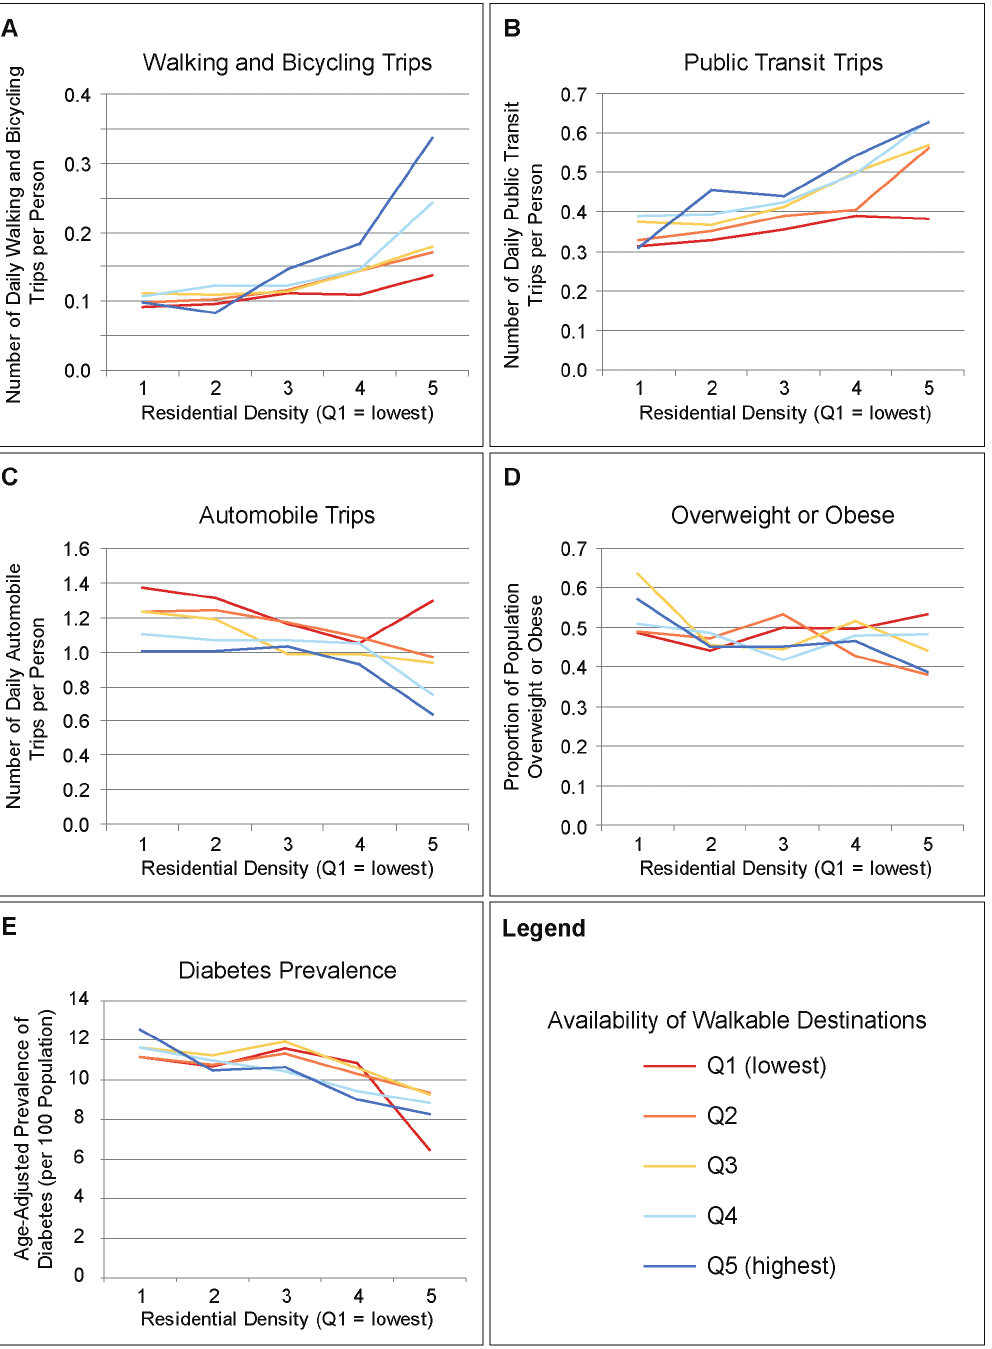
Figure 2. Transportation Behaviors and Health Outcomes by Residential Density and Availability of Walkable Destinations. These figures depict the interaction between density and destinations in relation to transportation behaviours and related health outcomes. The average daily number of trips per person by walking or bicycling, public transit, and automobile were derived from the Transportation Tomorrow Survey (2006) for residents age 11 years and older. Proportion of the population aged 30 to 64 years that were overweight and obese was derived from 2003–2008 Canadian Community Health Survey data. Age-sex adjusted prevalence of diabetes mellitus among adults aged 30 to 64 years was derived from the Ontario Diabetes Database, 2009. Residential density was calculated using data from the 2006 Canada Census and availability of walkable destinations was calculated using data from DMTI Spatial Inc. (2009), the City of Toronto (2009), and the Ministry of Education (2009).